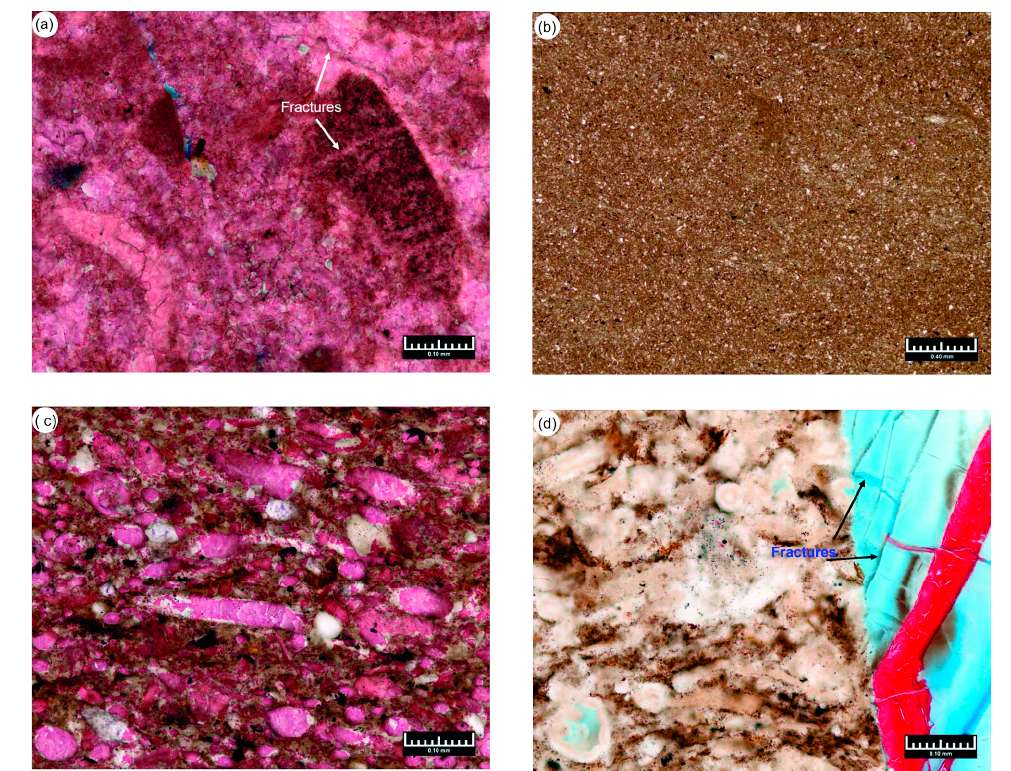
Figure 20. Photomicrographs of rotary core samples at different depths from well 6 showing ( a ) sample at depth of 5855 ft (~1786 m). Bulk mineralogy = 97.7% calcite, 1.2% dolomite, and 1.1% quartz. Fractures present but mostly resealed by calcite. ( b ) Sample at 5925 ft (1806 m). Dominant minerals = 60% clay, 30.7% quartz, and 7.7% feldspar. No visible porosity and few fractures replaced by pyrite. ( c ) Sample at 5945 ft (1812 m) spicule-rich bioclast packstone and mud-rich wackestone. Bulk 59.7% calcite, 24.8% quartz, and 9.5% clay. Diagenetic process mainly calcite and pyrite replacement of grains. No visible fractures. ( d ) Sample at 6303 ft (~1921 m) highly fractured sandstone and silicified sponge spiculite of deepwater origin. Dominant mineralogy = 98.7% quartz and 1.3% calcite. Most fractures such as stained red have been resealed.